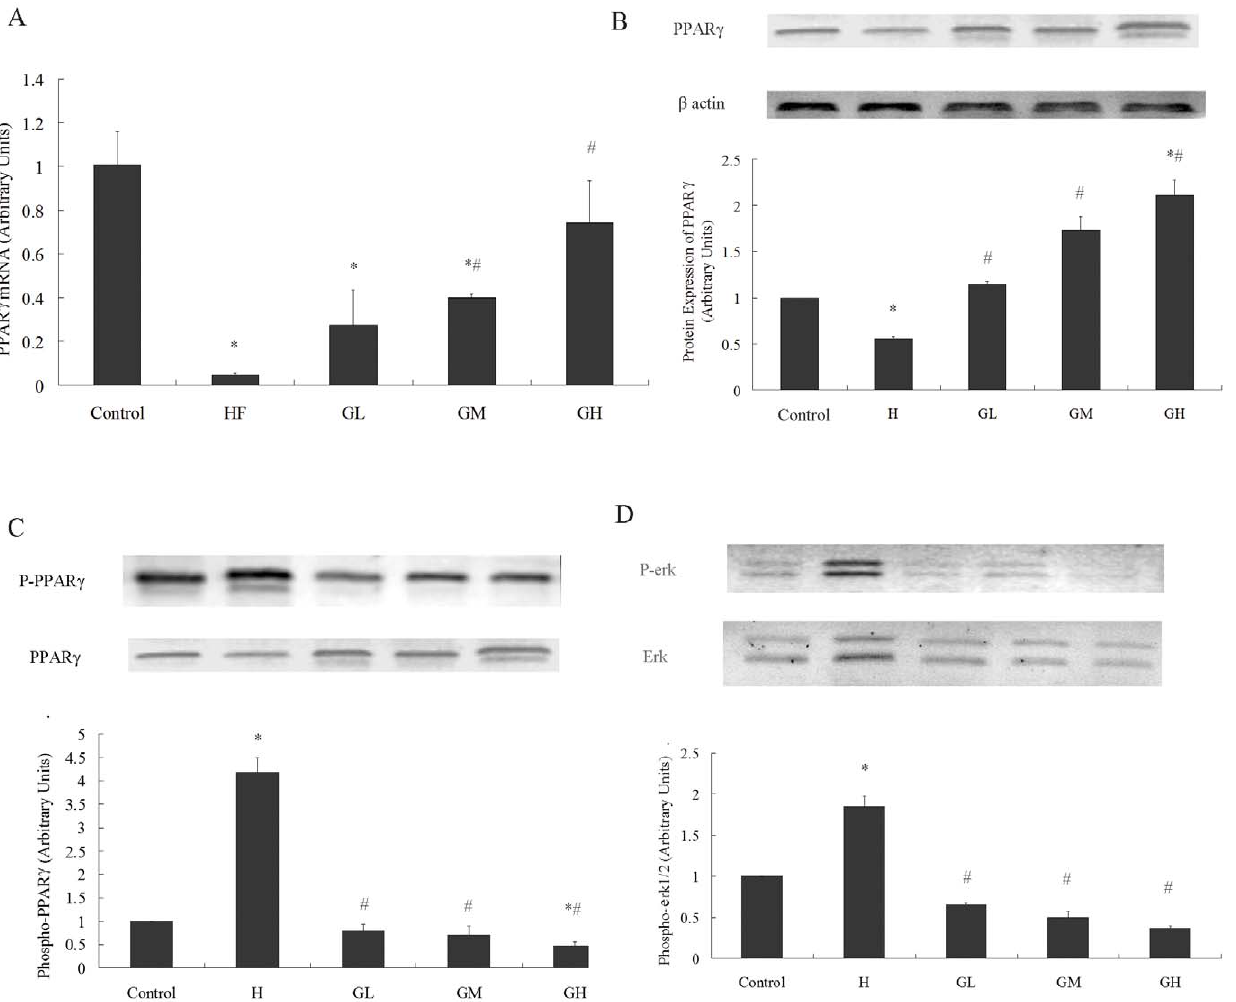
Figure 3. GTPs attenuated the phosphorylation, decreased expression of PPAR c and erk1/2 activation in fat tissue induced by HF diet. PPAR c mRNA level was calculated with GADPH as reference. Protein expression and phosphorylation of PPAR c and erk1/2 were tested by western blot; the results were presented in arbitrary units using beta-actin, PPAR c and erk1/2 as references, respectively. The value of the control group was considered as 1.00. HF down-regulated the mRNA (A, N=6) and protein expression (B, N=3) of PPAR c while up-regulated the phosphorylation of PPAR c (C, N=3) and erk1/2 (D, N=3), the effects could be ameliorated by GTPs treatment. (* P , 0.05 vs. the control; # P , 0.05 vs. the HF group). Data is expressed as Mean 6